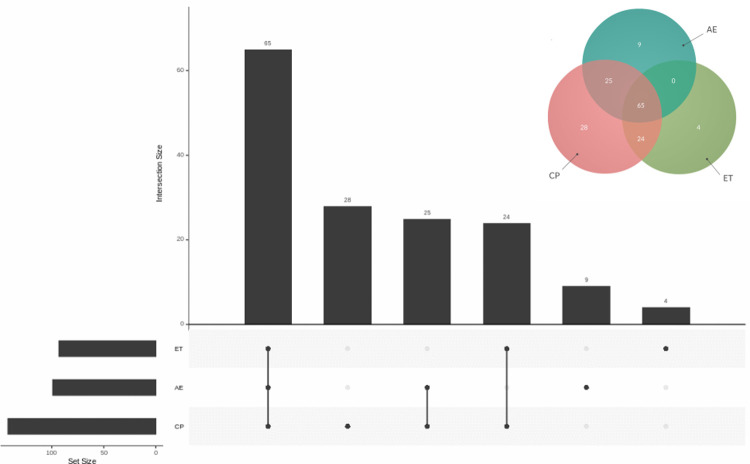
Venn diagram and UpSet plot of the Argentinian samples.Venn diagram and UpSet plot show the number of shared OTUs between chicken cecal Argentinian samples designated as ET: Experimental Trial, CP: Conventional Poultry, and AE: Agroecological Farm.